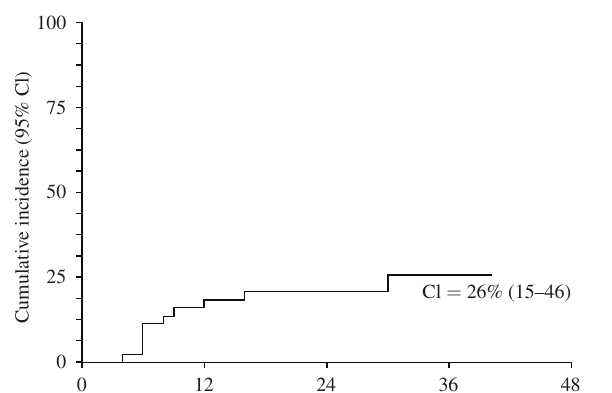
FIGURE 5: Cumulative incidence of treatment failure in 44 consecutive patients, receiving Imatinib for steroid-refractory cGVHD (Olivieri et al.